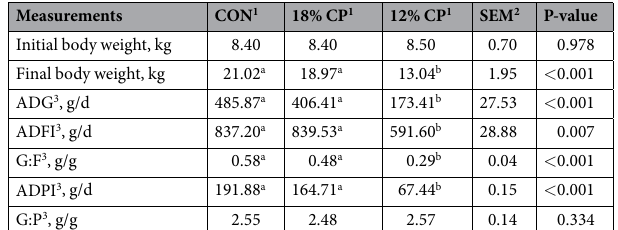
Table 1. Effect of dietary protein content on growth measurements. 1 CON, control diet with 24% crude protein (CP); 18% CP, low protein diet with 18% CP; 12% CP, low protein diet with 12% CP. 2 SEM: standard errors of means. 3 ADG: average daily gain; ADFI: average daily feed intake; G:F: gain:feed ratio; ADPI: average daily protein intake; G:P: gain:protein ratio. a,b Within a row, values with different superscripts are different (P < 0.05).